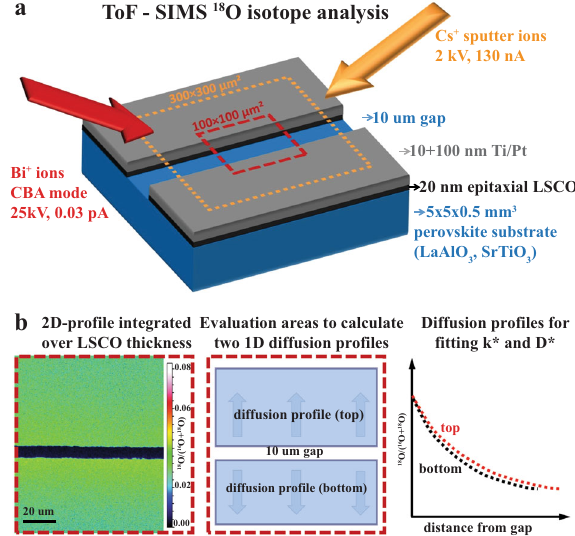
Fig. 2 Schematic of the in-plane isotope experiments. An LSCO thin fi lm is epitaxially grown on a perovskite substrate and a capping layer of 10 + 100 nm Ti + Pt is sputtered on top. Using photolithography and Ar + ion beam etching, a 10 µ m wide gap is opened in all layers and 18 O isotope exchange is performed via the exposed LSCO surface at both sides of the gap ( a ). By ToF-SIMS both sides of the gap are analyzed, and the collected 3D isotope distribution data is converted into two 1D in-plane diffusion pro fi les as shown schematically in b